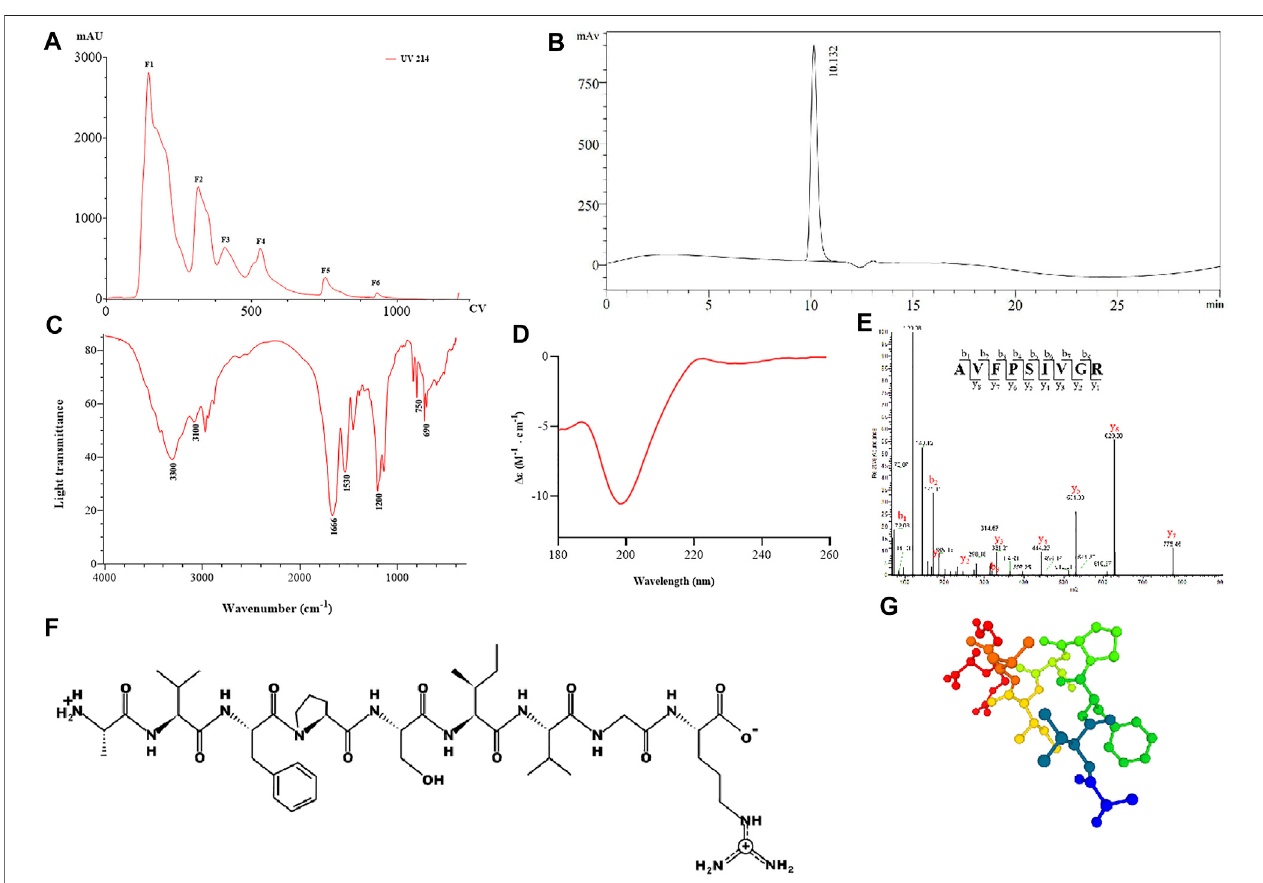
FIGURE 1 | Results of separation and structural analysis of AR-9. (A) Anion-exchange chromatography elution curve, (B) RP-HPLC of F1-F6, (C) IR spectrum of AR-9, (D) CD spectrum of AR-9, (E) corresponding sequence was determined from this spectrum as AVFPSIVGR, (F) and (G) molecular structure and conformational prediction of